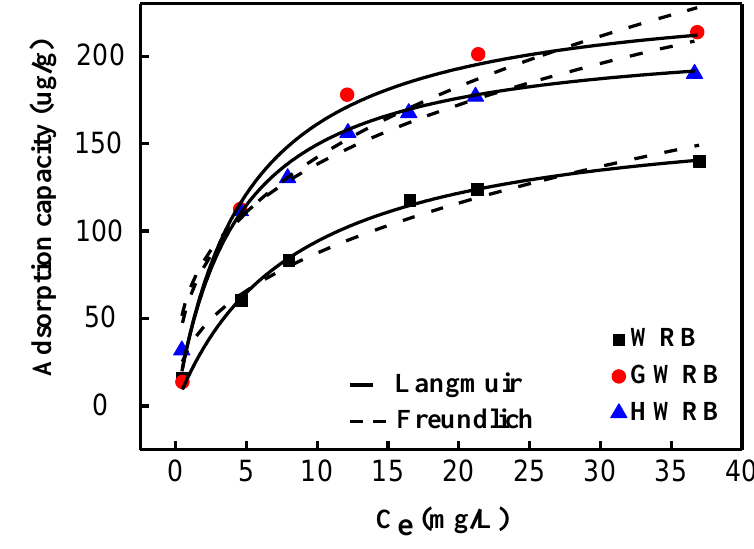
Figure 5. Adsorption isotherms of cimetidine onto WRB, GWRB, and HWRB. Table 4. The parameters and correlation coe ffi cients of Langmuir and Freundlich adsorption isotherms.